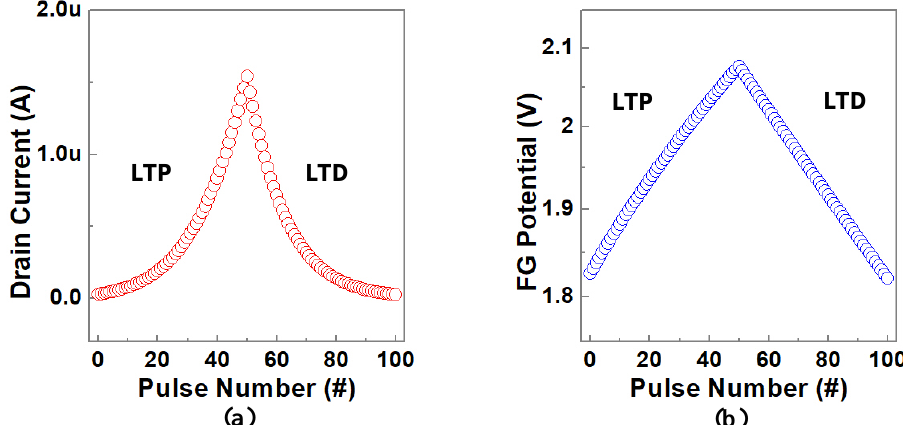
Figure 7. Long-term potentiation (LTP) / long-term depression (LTD) characteristics of UFGM with p +